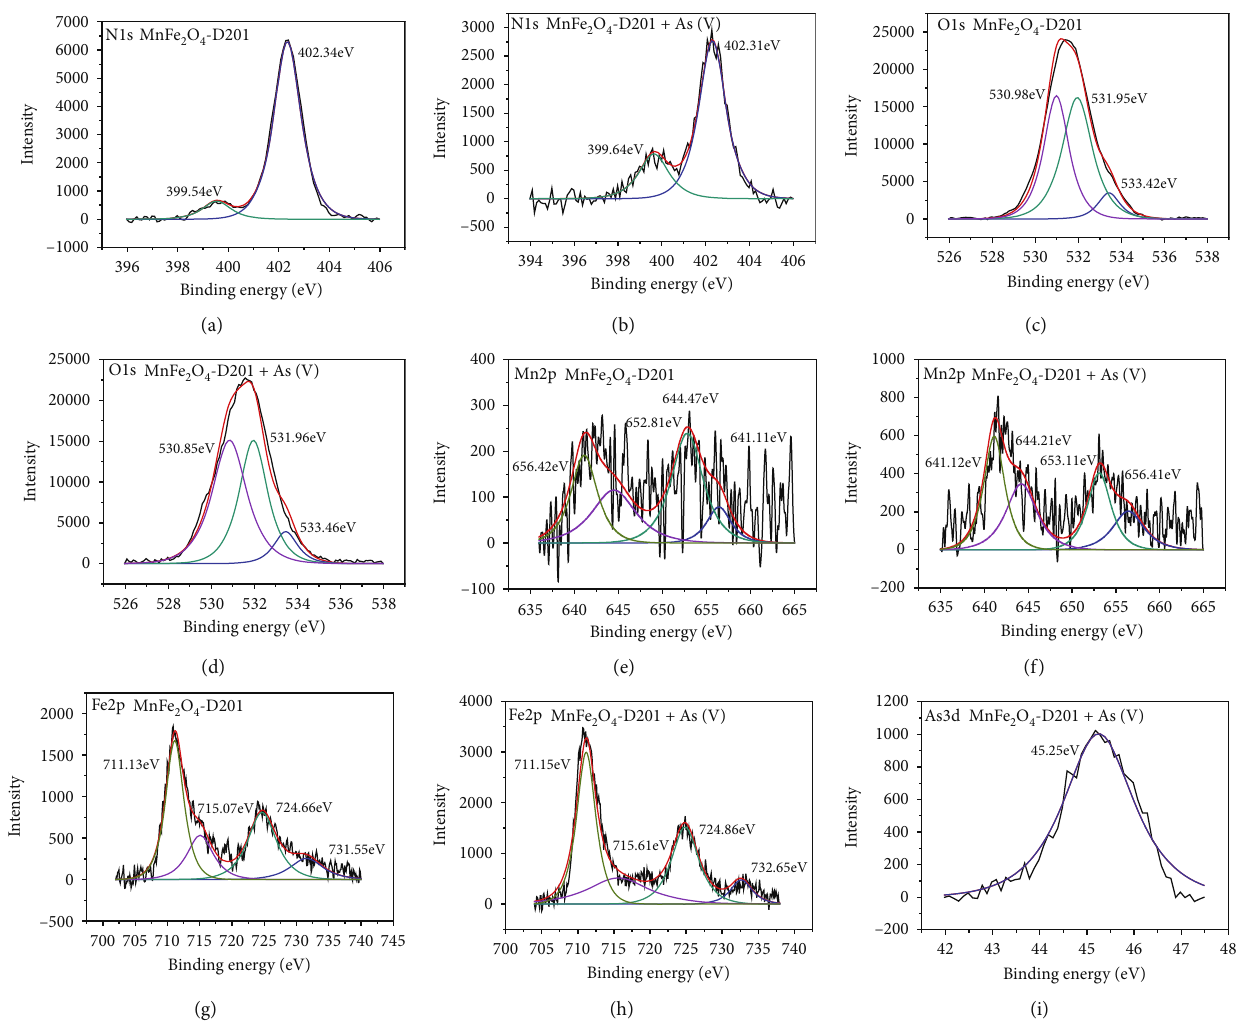
Figure 8: N1s (a, b), O1s (c, d), Mn2p (e, f), Fe2p (g, h), and As3d (i) XPS spectra of MnFe